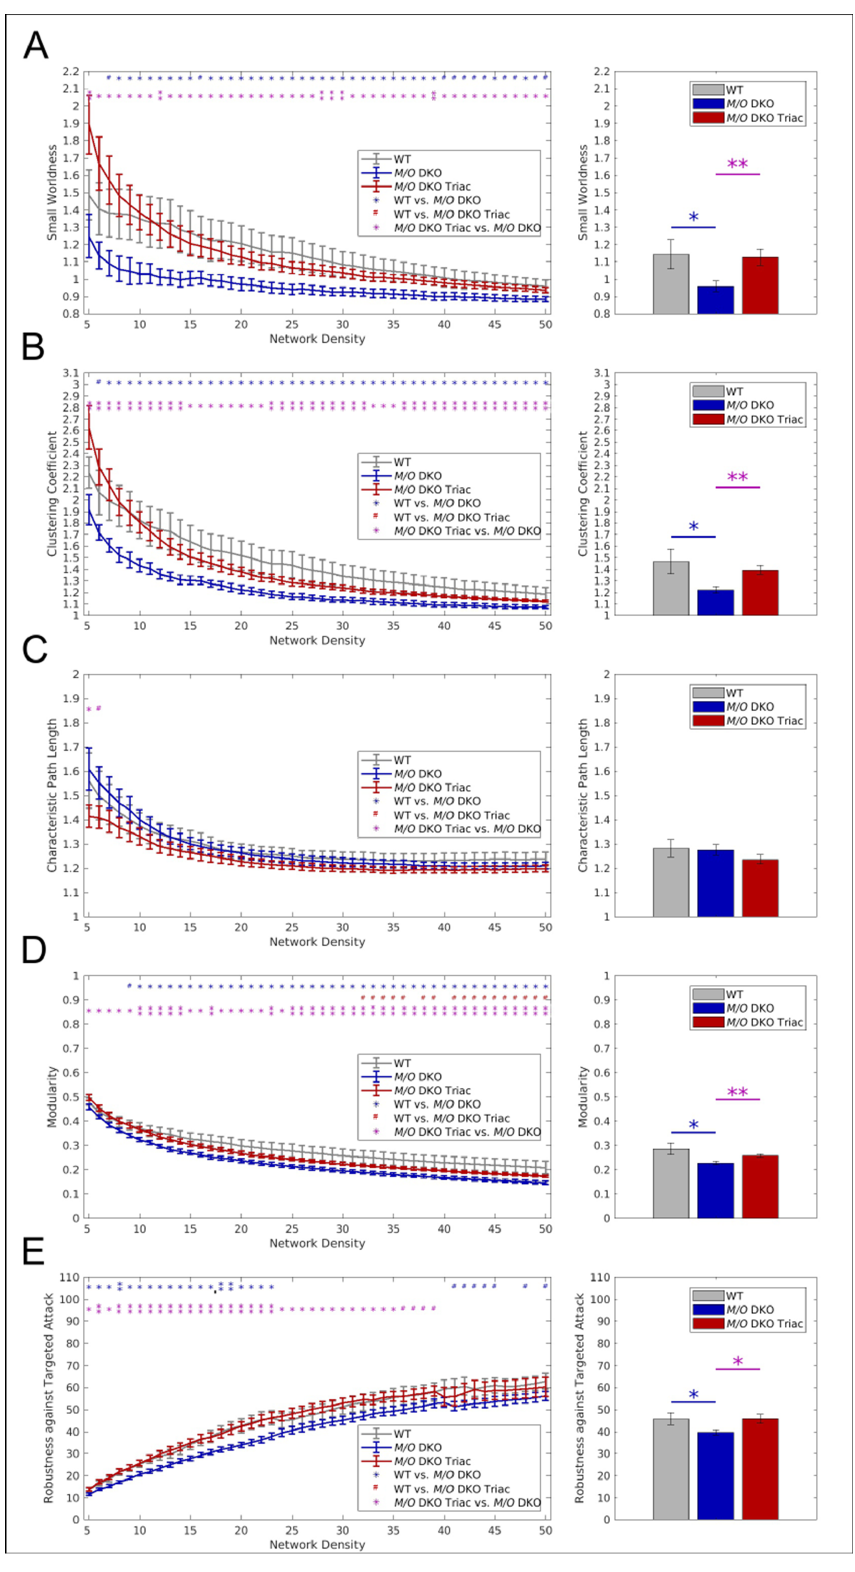
Figure 4. The differences in global graph metrics between WT, Mct8/Oatp1c1 DKO and Mct8/Oatp1c1 DKO TRIAC mice. Five global graph metrics are illustrated over network densities from 5% to